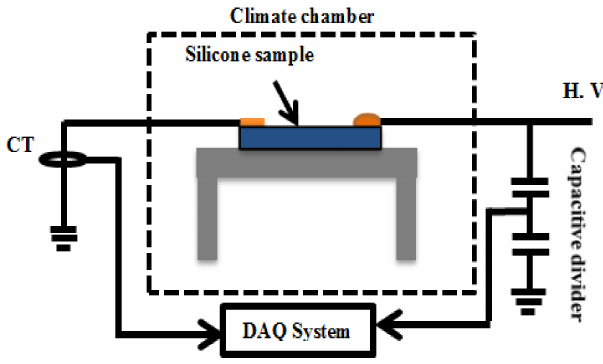
Figure 15. HV test setup.